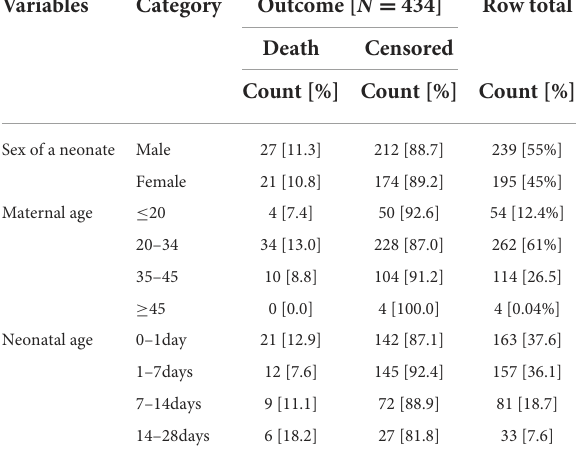
TABLE 1 Socio-demographic characteristics of neonate and mother in NICU, TASH, Addis Ababa, Ethiopia, from 1 January 2015 – 30 December